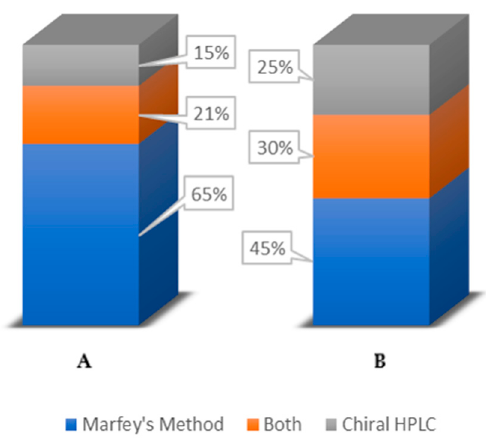
Figure 21. Distribution of the studies concerning the determination of the stereochemistry of marine peptides according to the method used before ( A ) and after 2007 ( B ).